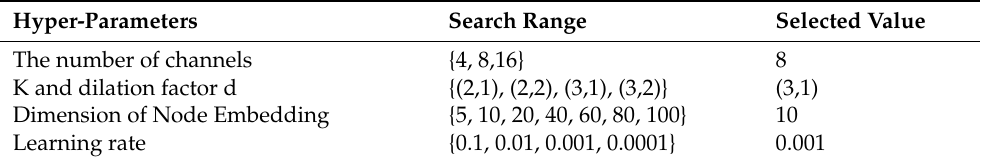
Table 5. Detail of hyper parameters.